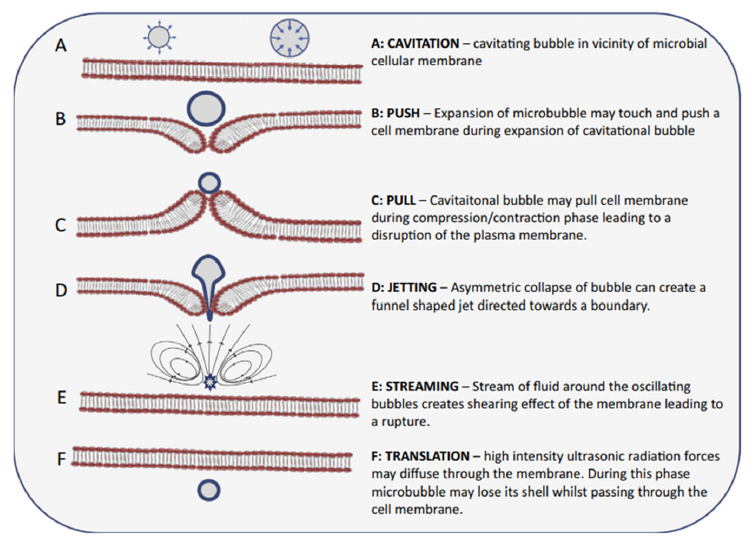
Figure 1. Sonoporation mechanism occurred during the ultrasound-assisted microbial inactivation process. Reproduced from [36] with permission from Elsevier, 2022.